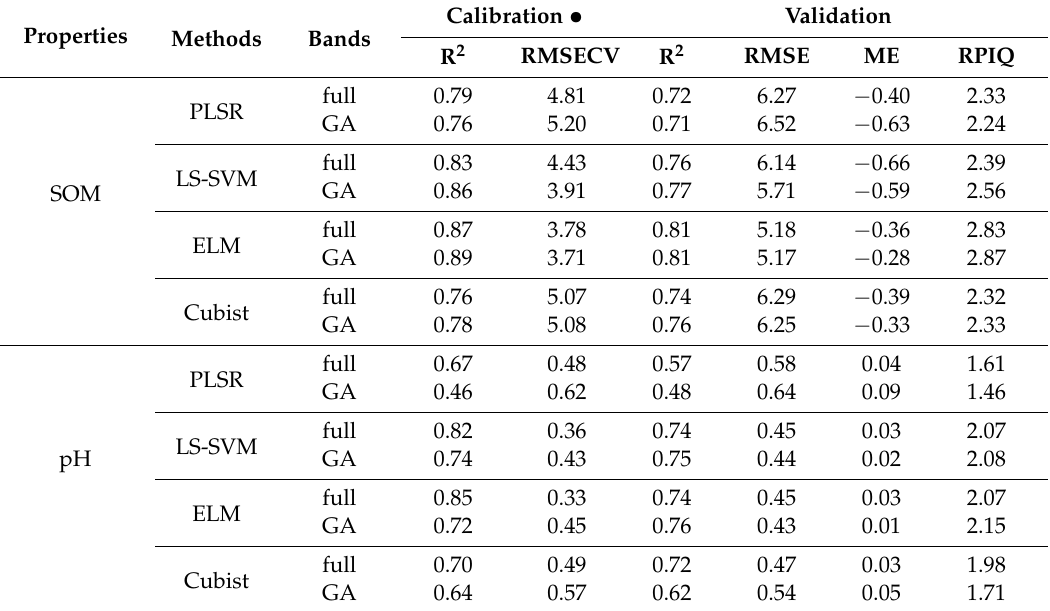
Table 3. Accuracy of different methods for prediction of SOM and pH based on full bands and GA selection bands in the calibration datasets and validation